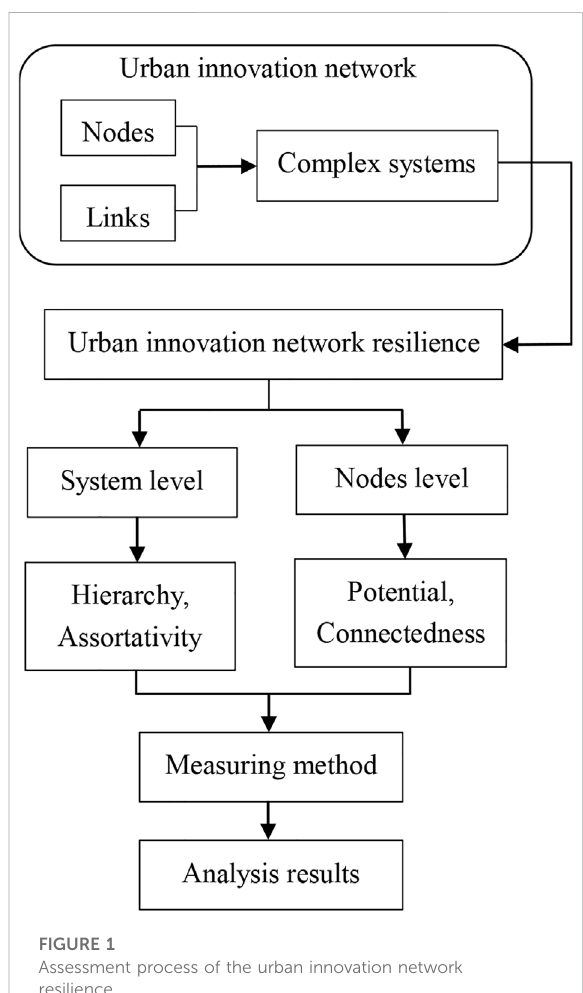
Assessment process of the urban innovation network